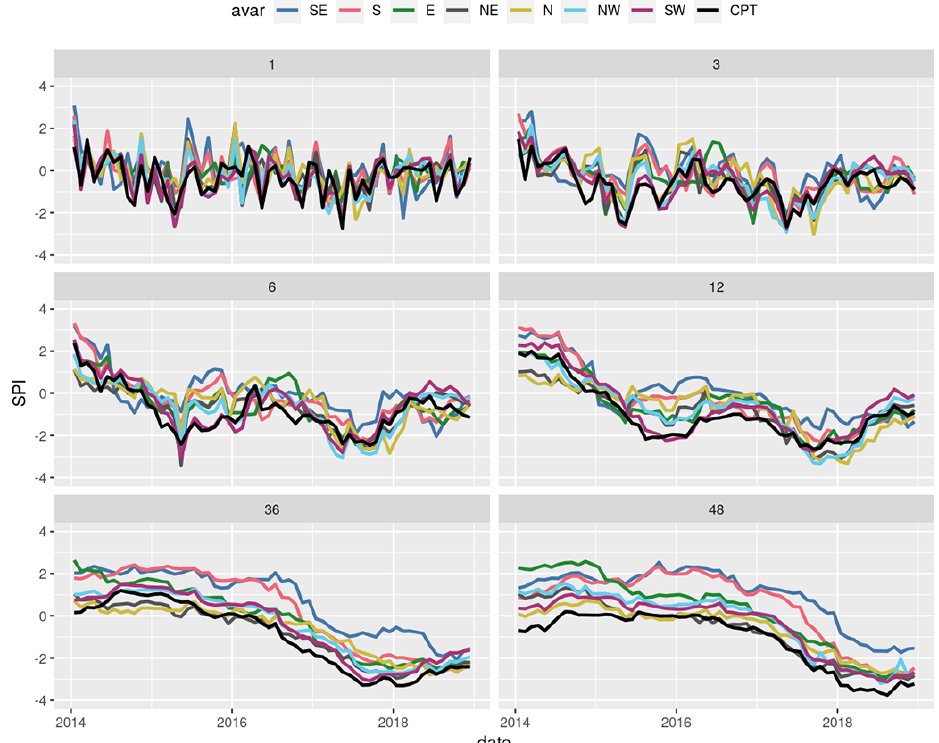
Figure 2. As in Fig. 1 but for the period 2014–2018 only and considering the annual variability clusters of Conradie et al. (2022) mapped in Fig.